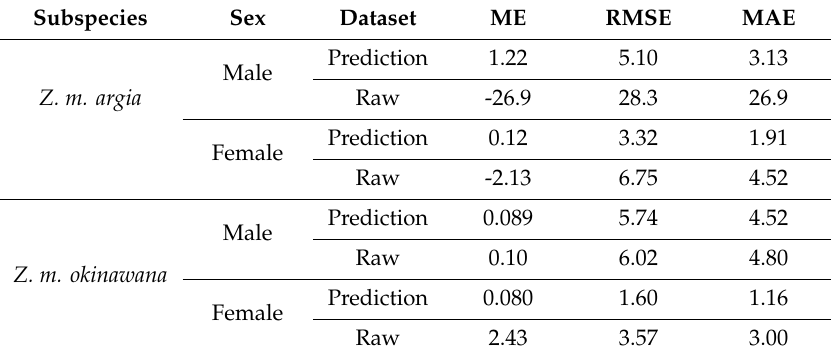
Table A4. Accuracy of the ARIMA prediction of each